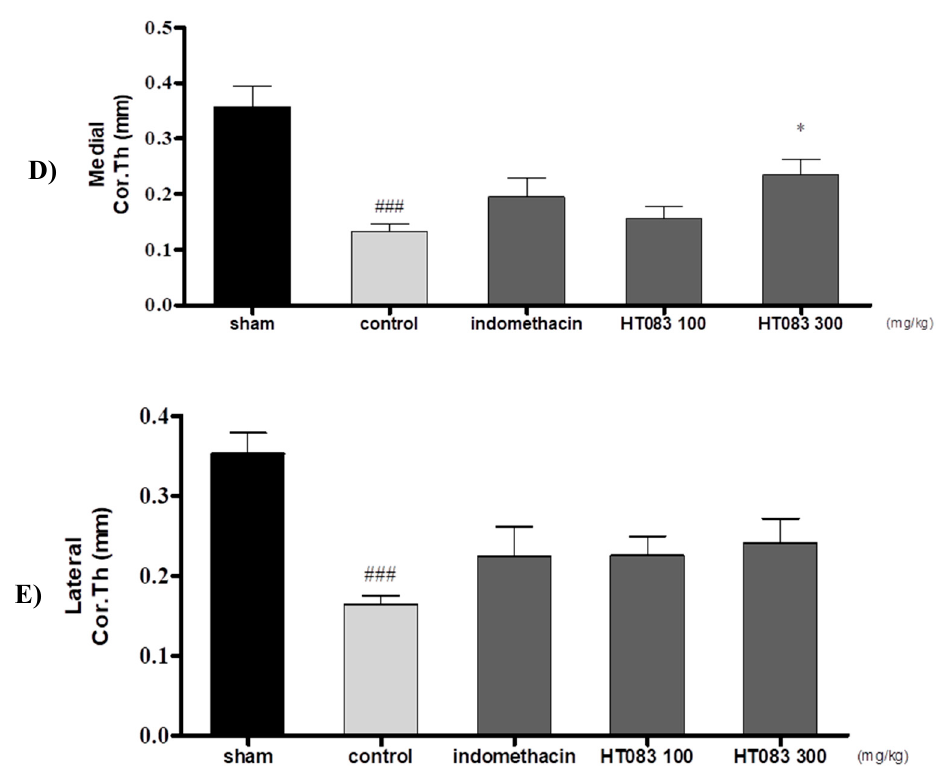
Figure 3. E ff ects of HT083 on the cartilage and subchondral bone damage. ( A ) Macroscopic images of the articular surfaces of tibia and femur of the sham and MIA rats ( B ) Axial Micro-computed tomography (Micro-CT) image of a rat tibia, in the medial (M) and lateral (L) subchondral bone compartment ( C ) Micro-CT images of the cartilage surface of the sham and MIA rats. ( D , E ) Histomorphometry parameters obtained by micro-CT of subchondral medial and lateral cortical thickness (Cor.Th). Each value is the mean ± SEM. The number of animals was nine in each group; * p < 0.001 vs. control and ### p < 0.001 vs sham (one-way ANOVA, Dunnett’s post hoc test).